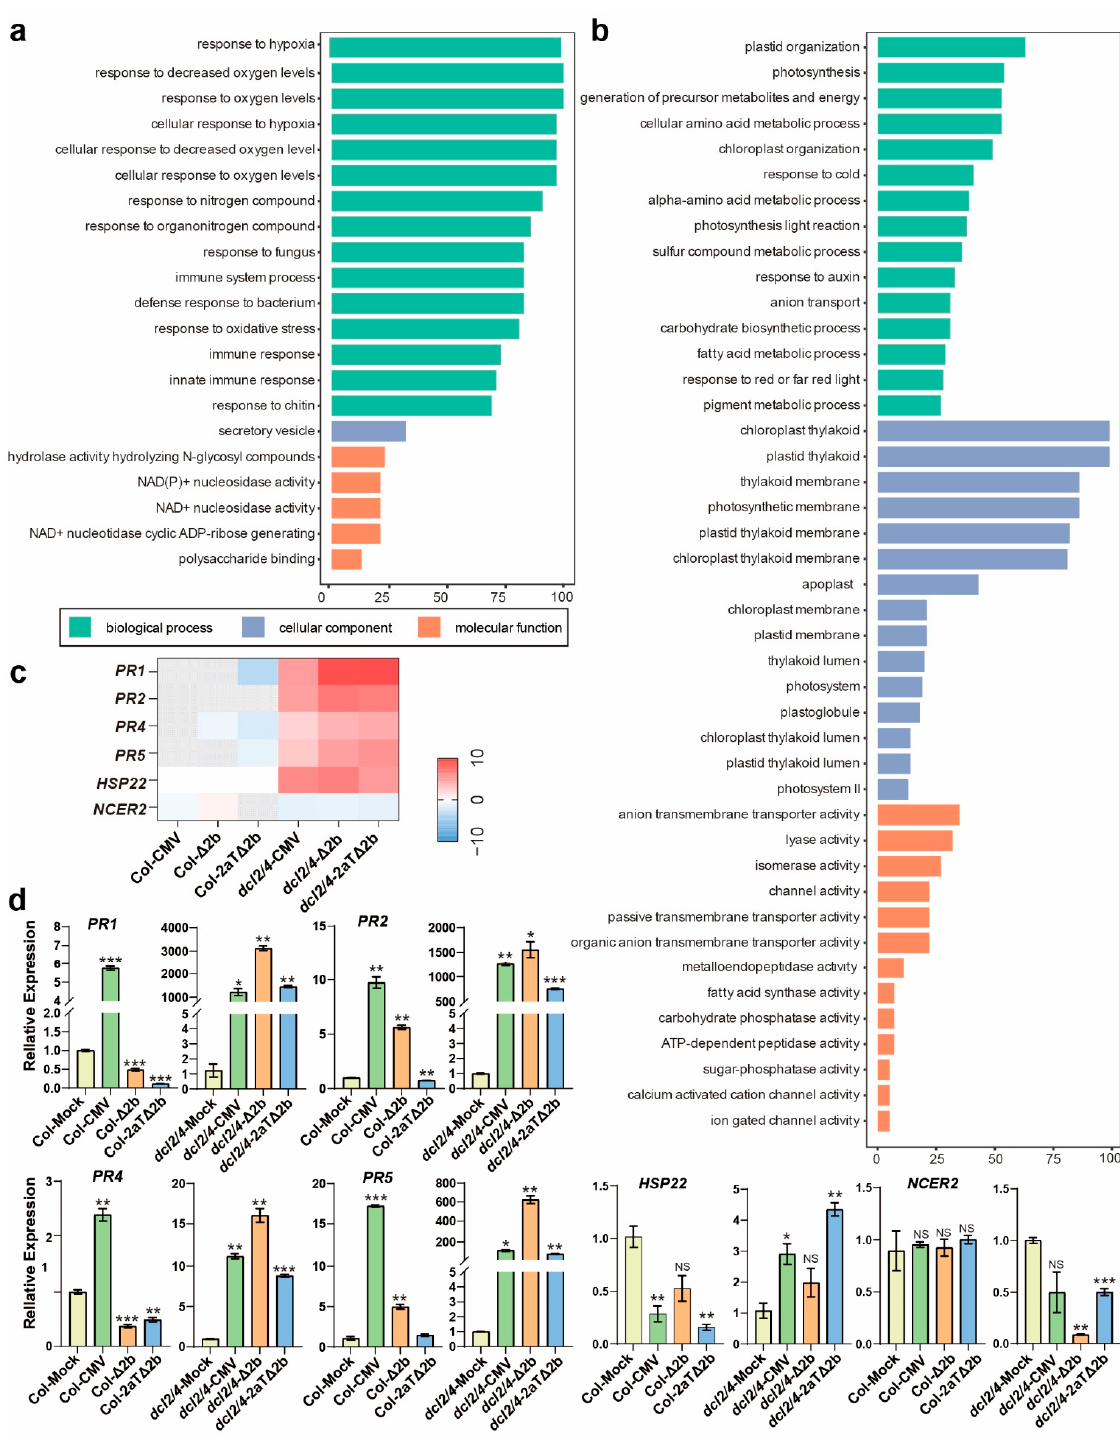
Figure 5. DEGs specifically overlapped in dcl2/4 -CMV, dcl2/4 - Δ 2b, and dcl2/4 -2aT Δ 2b. ( a ) GO terms enriched for induced DEGs. ( b ) GO terms enriched for suppressed DEGs. The y-axis represents the enriched GO term, and the x-axis represents the number of DEGs in the term. Different colors are used to distinguish biological processes, cellular components and molecular functions. ( c ) Heat map of part DEGs changed dramatically in sick dcl2/4 plants. ( d ) Relative transcriptional level of PR1 , PR2 , PR4 , PR5 , HSP22 and NCER2 . Values are means ± SEM. *, P < 0.05; **, P < 0.01; ***, P < 0.001; NS, no significance ( n = 3, two-tailed Student’s t